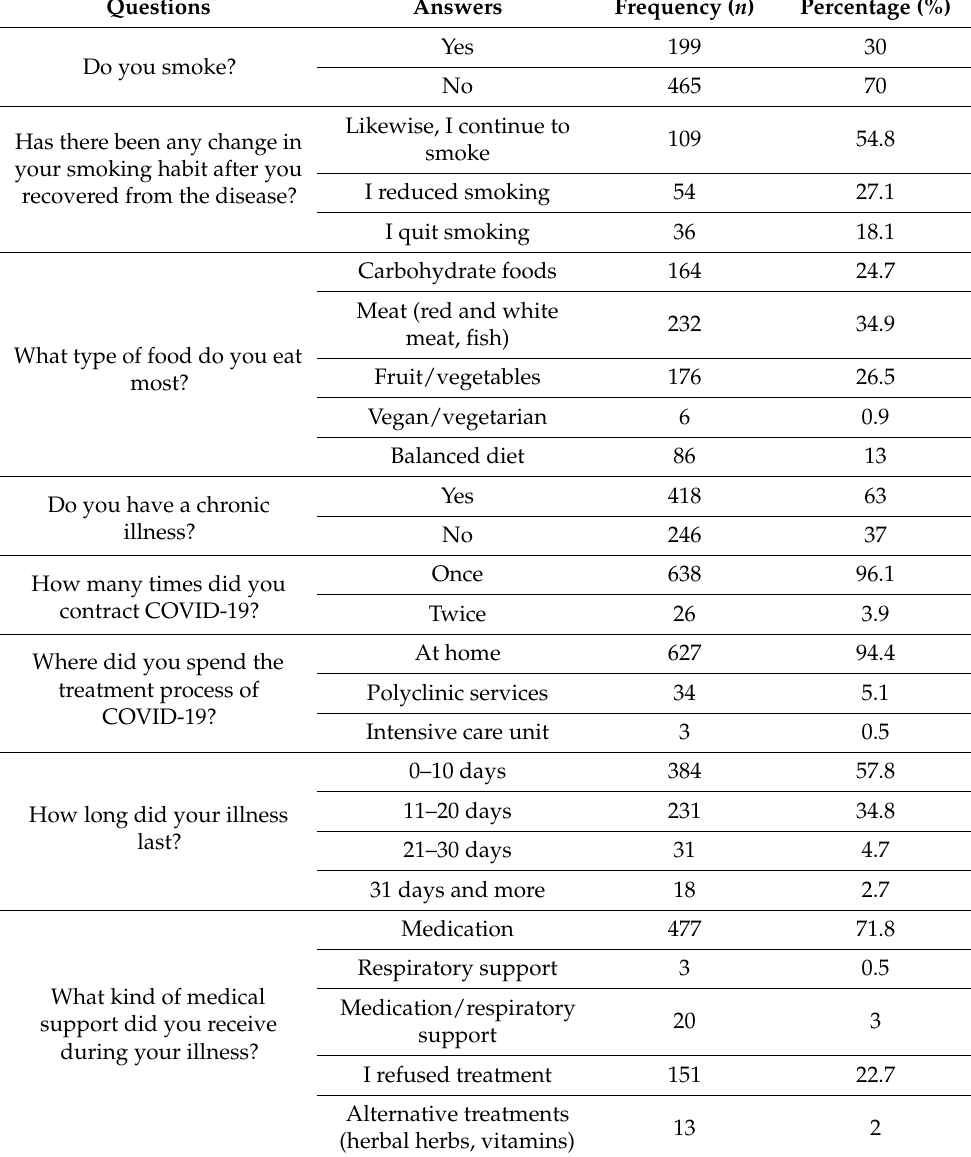
Table 2. Some characteristic features of the participants associated with